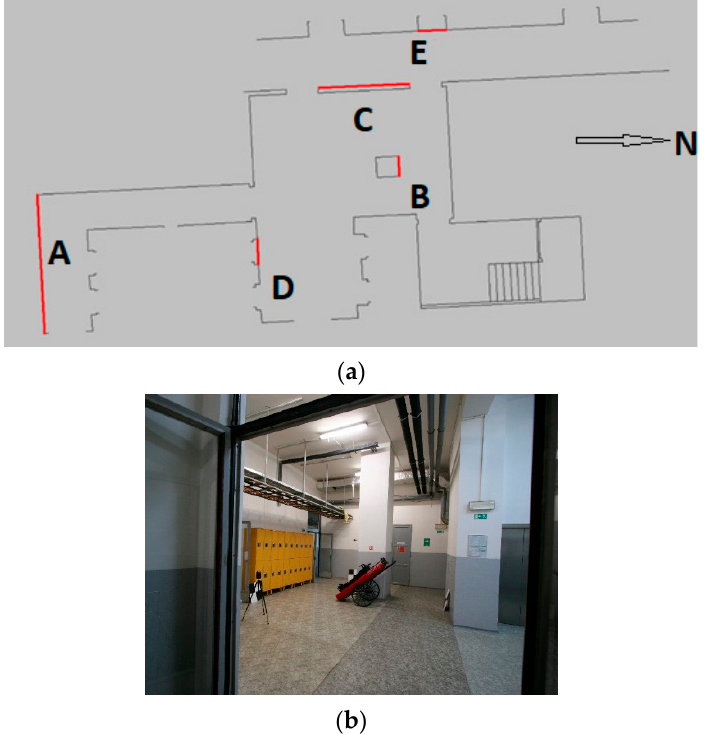
Figure 5. ( a ) Floor plan and analyzed distances in the faculty basement, ( b ) a view of the faculty basement part.